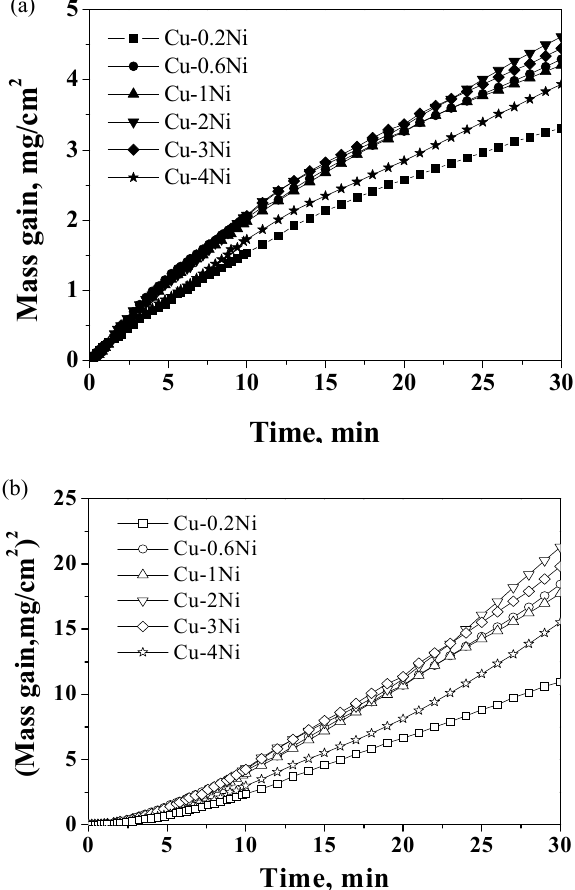
Figure 1. Kinetic curves for the oxidation of the six binary Cu-Ni alloys at 800°C in 1 atm O 2 for 30 min. (a) Normal plots; (b) Parabolic plots.